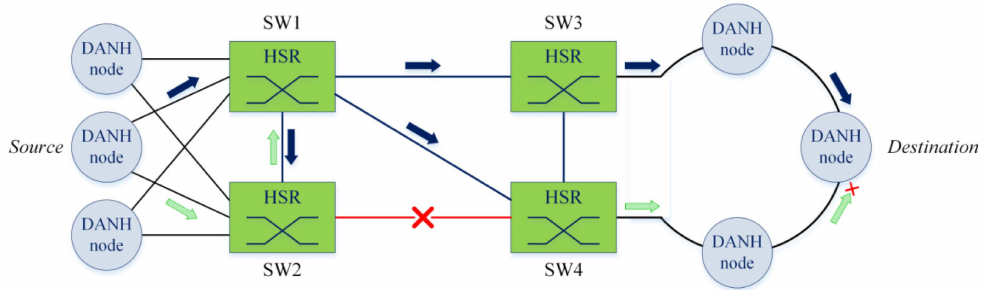
Figure 14. Forwarding a unicast frame in the case of a link